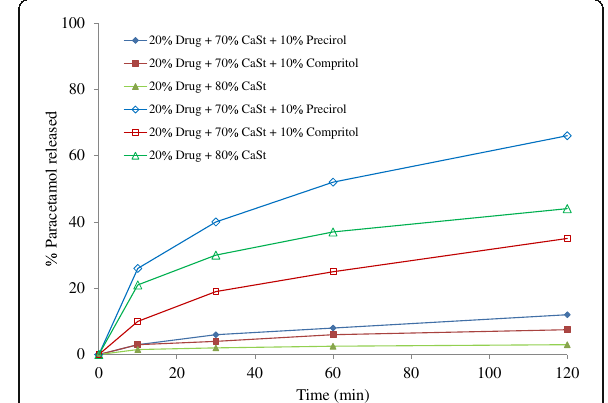
Fig. 28 Dissolution proifles of verapamil from four